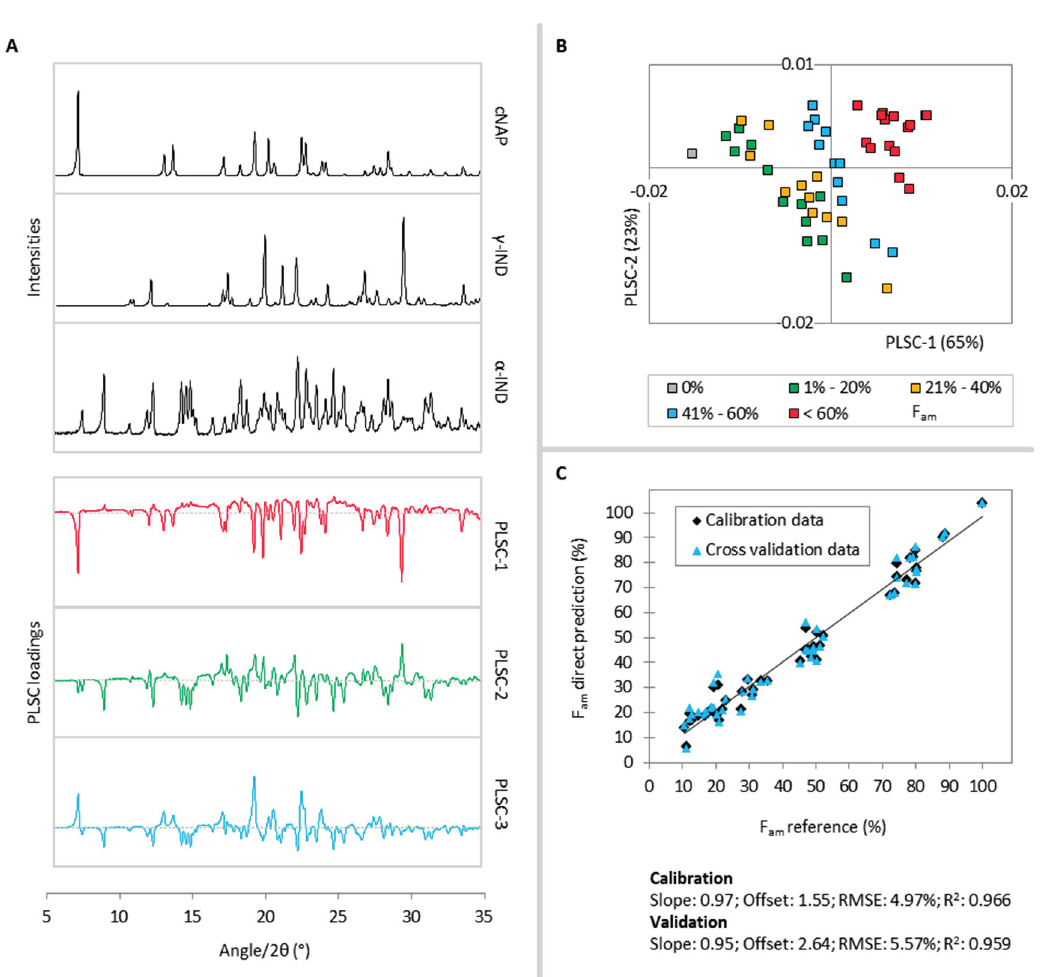
Figure 5. ( A ) Reference diffractograms of cNAP, γ -IND, α -IND (black lines) and PLSC-1 (red), PLSC-2 (green) and PLSC-3 (blue) loadings plots for the F am PLS model; ( B ) PLSC-1- vs. -PLSC-2 scores plot, the different colors classify the calibration samples according to their amorphous fractions; ( C ) Correlation of the PLS predicted amorphous fraction vs. the reference values during the calibration (black diamonds) and cross validation (blue